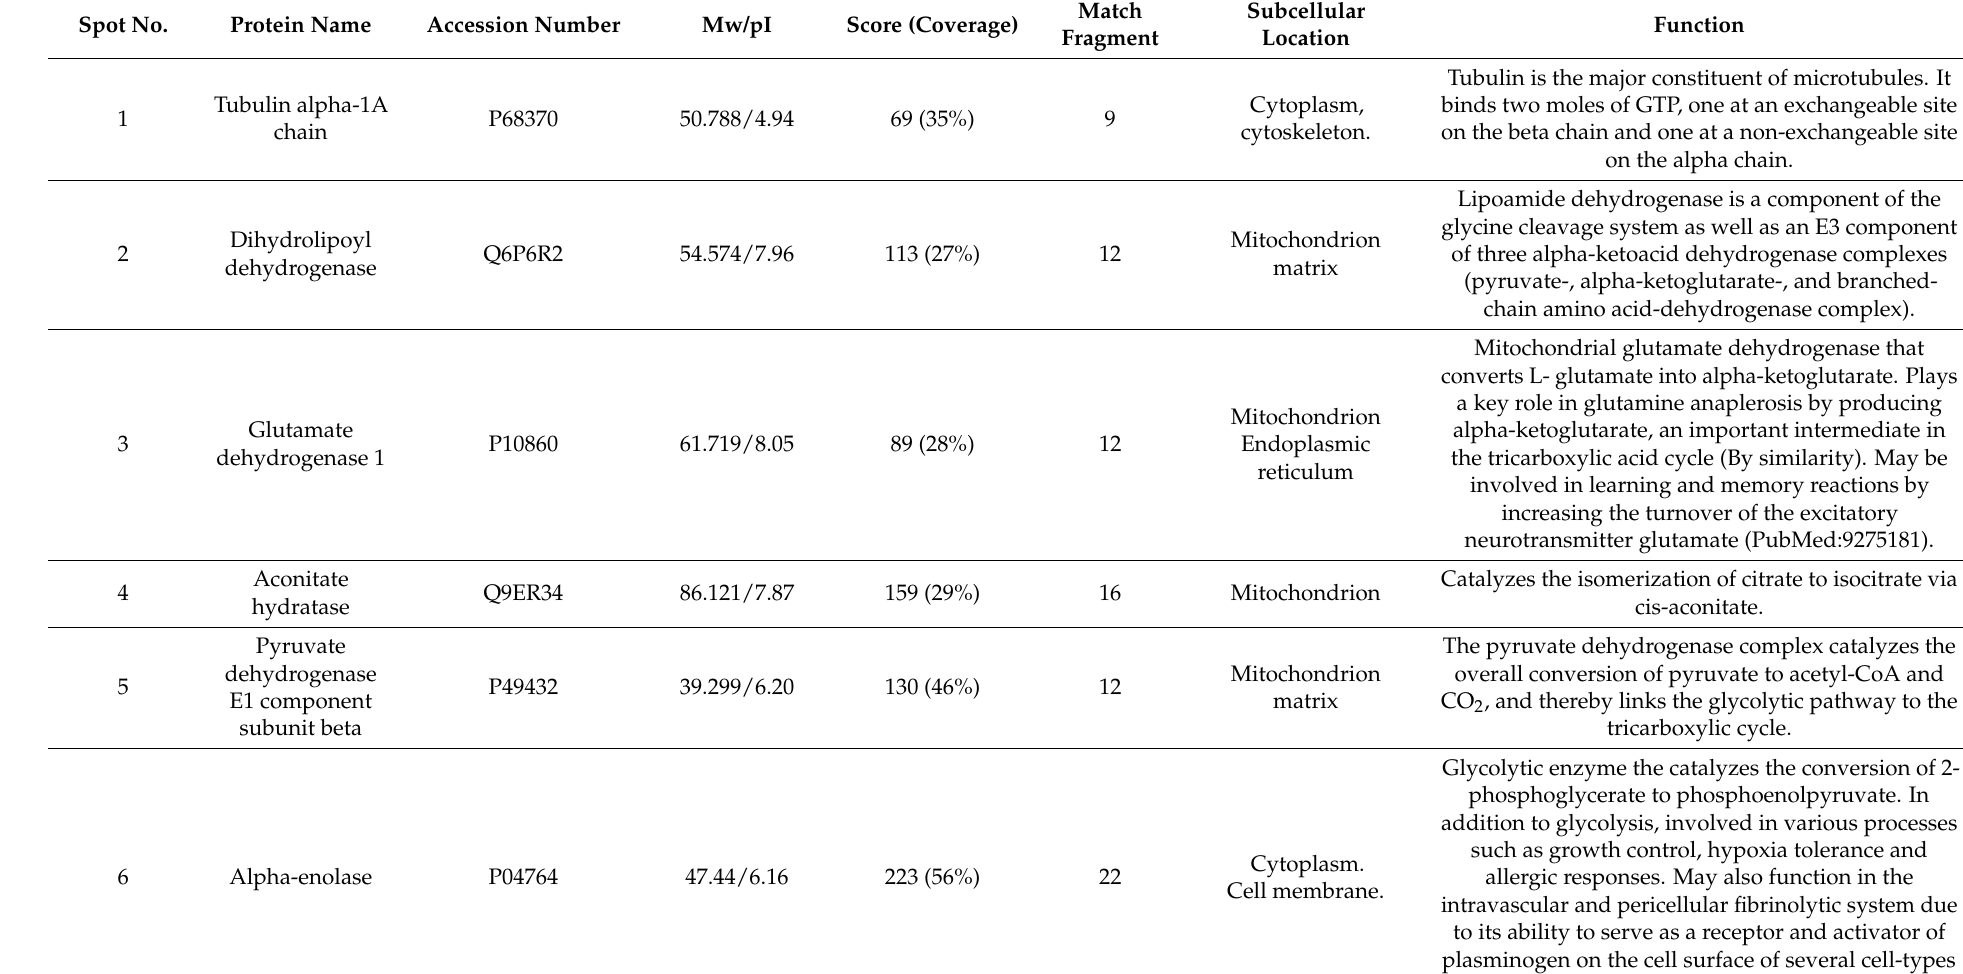
Table 1. List of identified protein